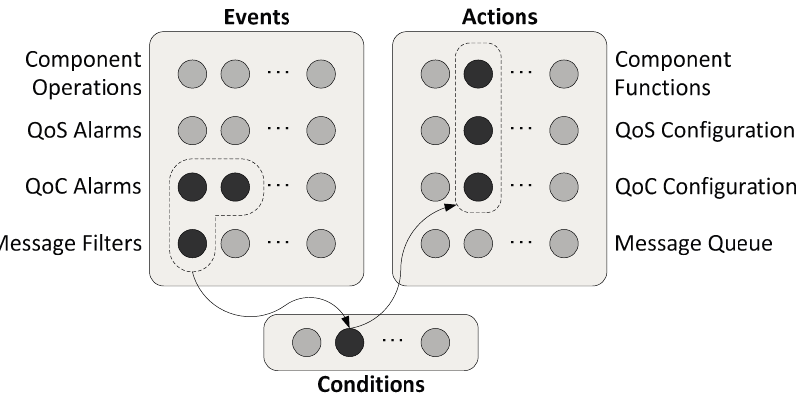
Figure 13. Conceptual model of event management with the source of “Events”, “Conditions” and “Actions”.